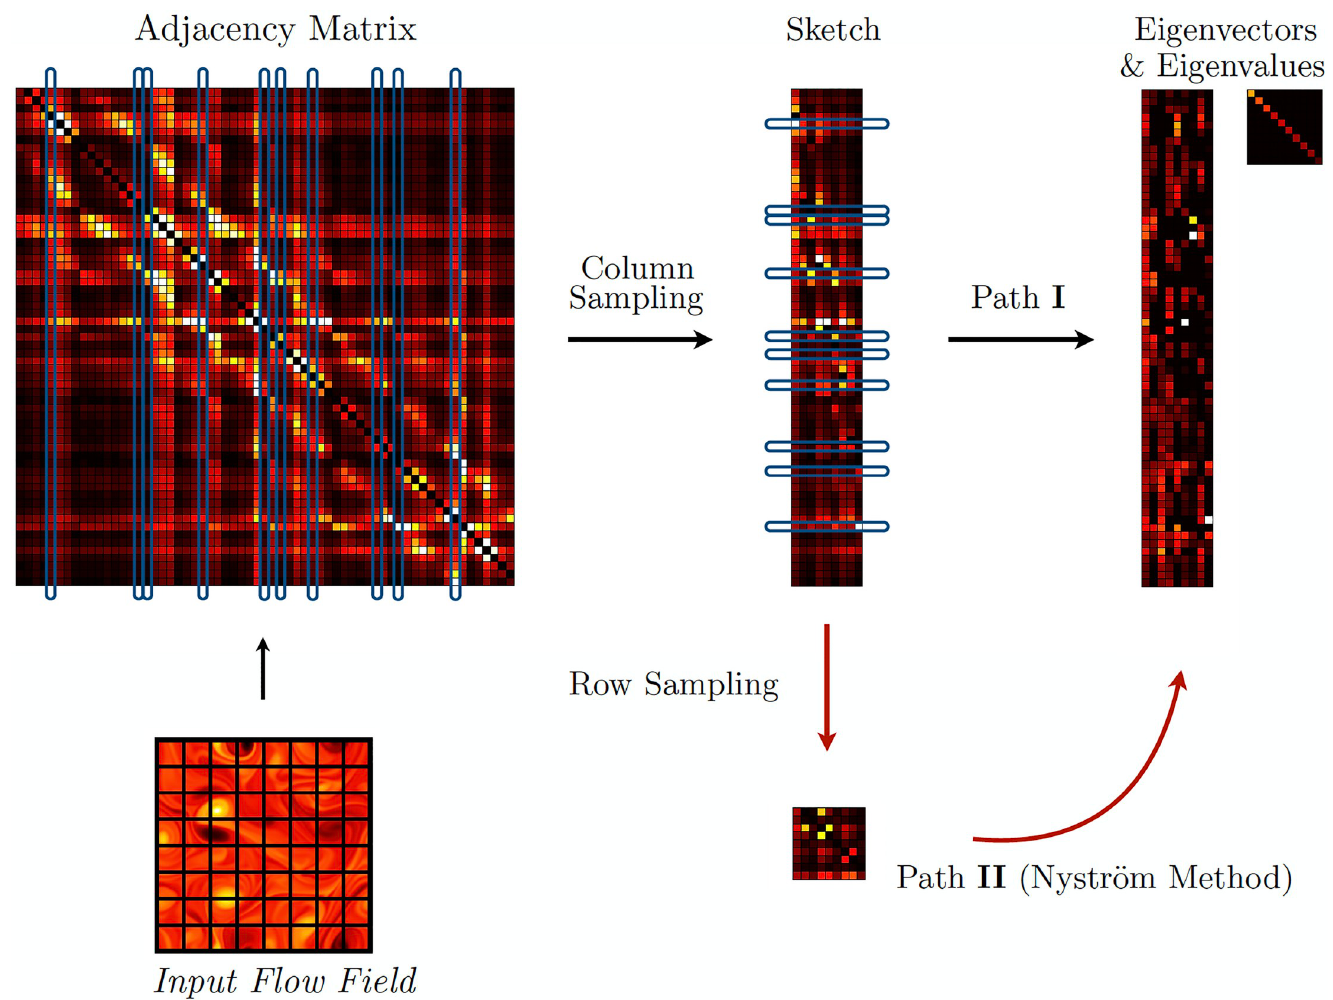
Fig 1. Identification of dominant eigenvalues and eigenvectors of the adjacency matrix obtained from a fluid flow field using randomized methods. Path I randomly samples columns of the adjacency matrix to approximate the leading eigenvalues and eigenvectors; path II uses both column and row sampling to form a sketch. Note, it is not required to explicitly construct the full adjacency